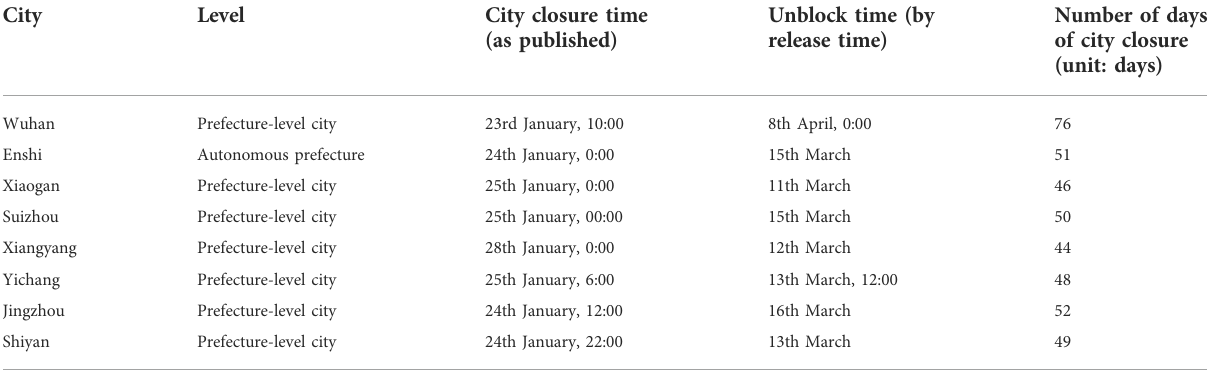
TABLE 1 Closing and unclosing time of each